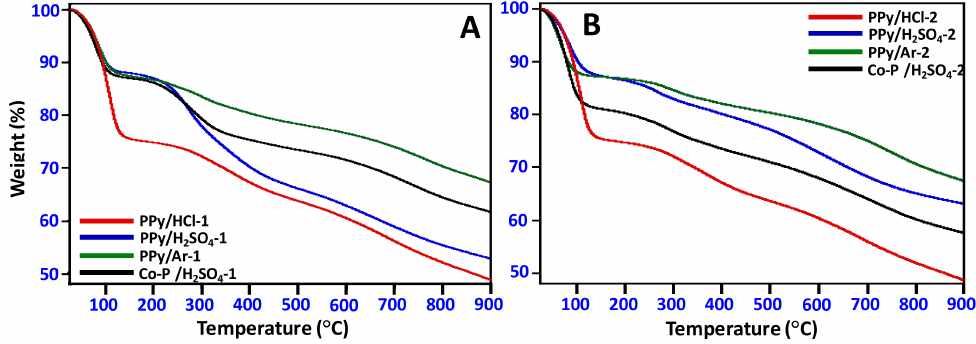
Figure 9. TGA thermograms obtained for ( A ) N-GOs obtained when carbonization and activation were carried using polymer: KOH in the ratio of 1:2; ( B ) N-GOs obtained when carbonization and activation were carried using polymer: KOH in the ratio of